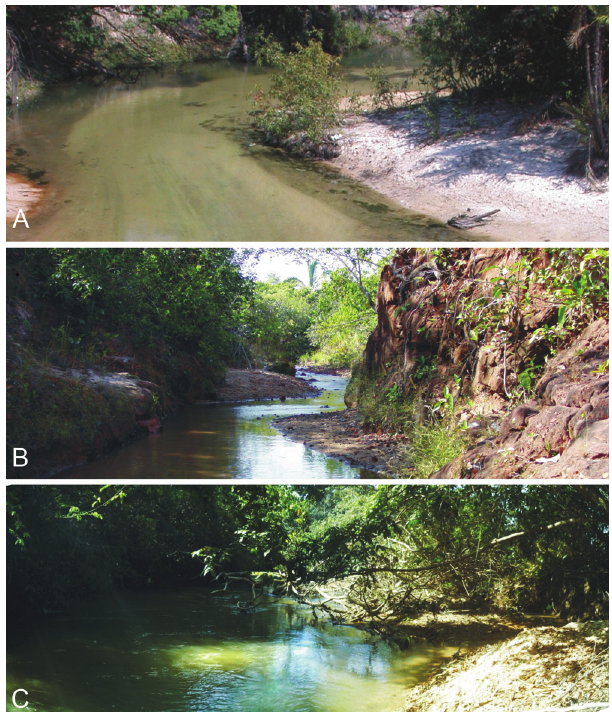
Fig. 3. ( A ) rio Cristalino, rio Araguaia basin, Mato Grosso State (photo by José Birindelli), ( B ) córrego Jaraguá, rio Araguaia basin, Goiás State, and ( C ) rio Corrente, rio das Mortes basin, Mato Grosso